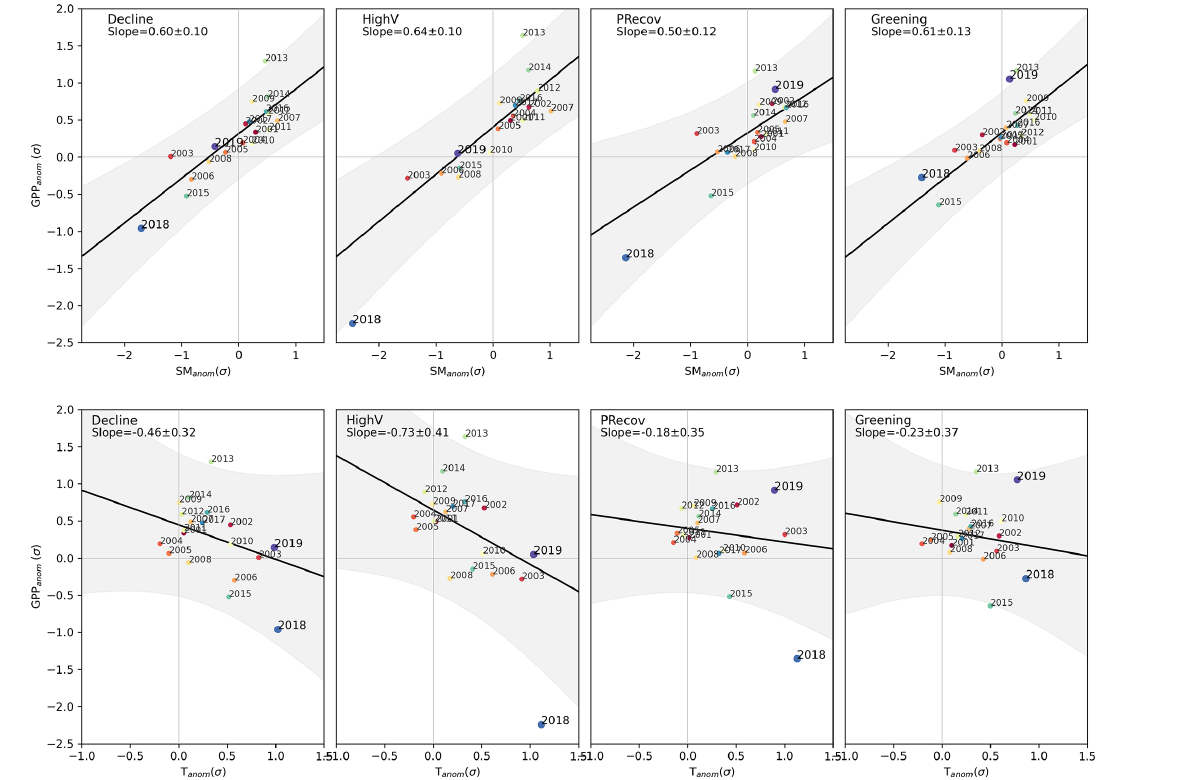
Figure B8. The same as Fig. 4 but for GPP and soil moisture anomalies simulated by a subset of land surface models from (Bastos et